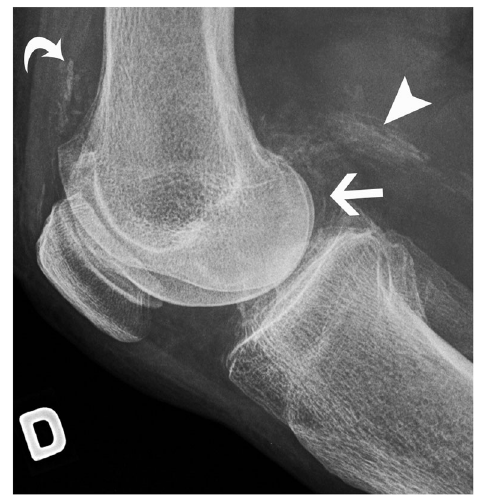
Fig. 9 CPPD crystal deposition disease in the knee. Lateral radiograph of the right knee shows chondrocalcinosis in hyaline cartilage at the posterior femoral condyle (arrow), in the gastrocnemius proximal tendon (arrowhead) and in the synovial lining at the suprapatellar recess (curved arrow)